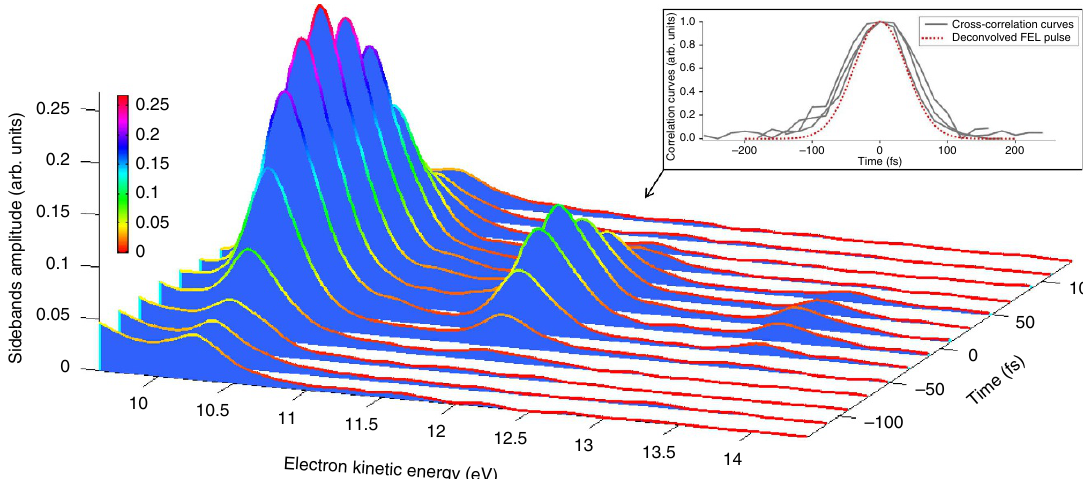
Figure 2 | Measurement of the FEL pulse duration. Photo-electron spectra, obtained by inverting the electron distributions acquired with the VMI spectrometer (see Fig. 1), as a function of the delay between the FEL and infrared pulses. The reported measurement refers to the ‘standard’ working conditions, that is, no stretching of the seed, no FEL compression. For the sake of visualization, only the first, second and third sidebands (normalized to the main line, associated to the direct photoemission process) are plotted. The inset shows three independent cross-correlation curves obtained by plotting the area under the peak of the second sideband as a function of the FEL-infrared delay. Also shown (dotted curve) is the deconvolved FEL pulse, which has an estimated duration of about 91fs. NATURE COMMUNICATIONS|7:13688|DOI: